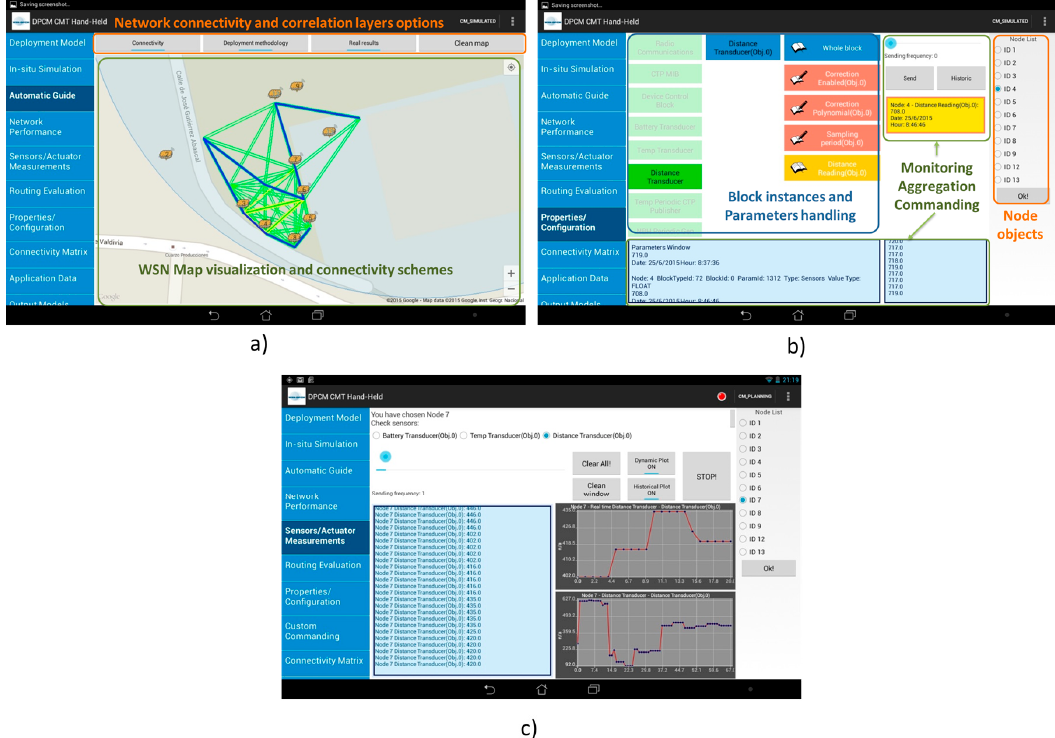
Figure 20. General view of Hand-held top-level interface in Commissioning and Maintenance Tool. ( a ) Network connectivity and node correlation scheme layers; ( b ) Runtime node functional components management; ( c ) Data aggregation and on-site monitoring/commanding.